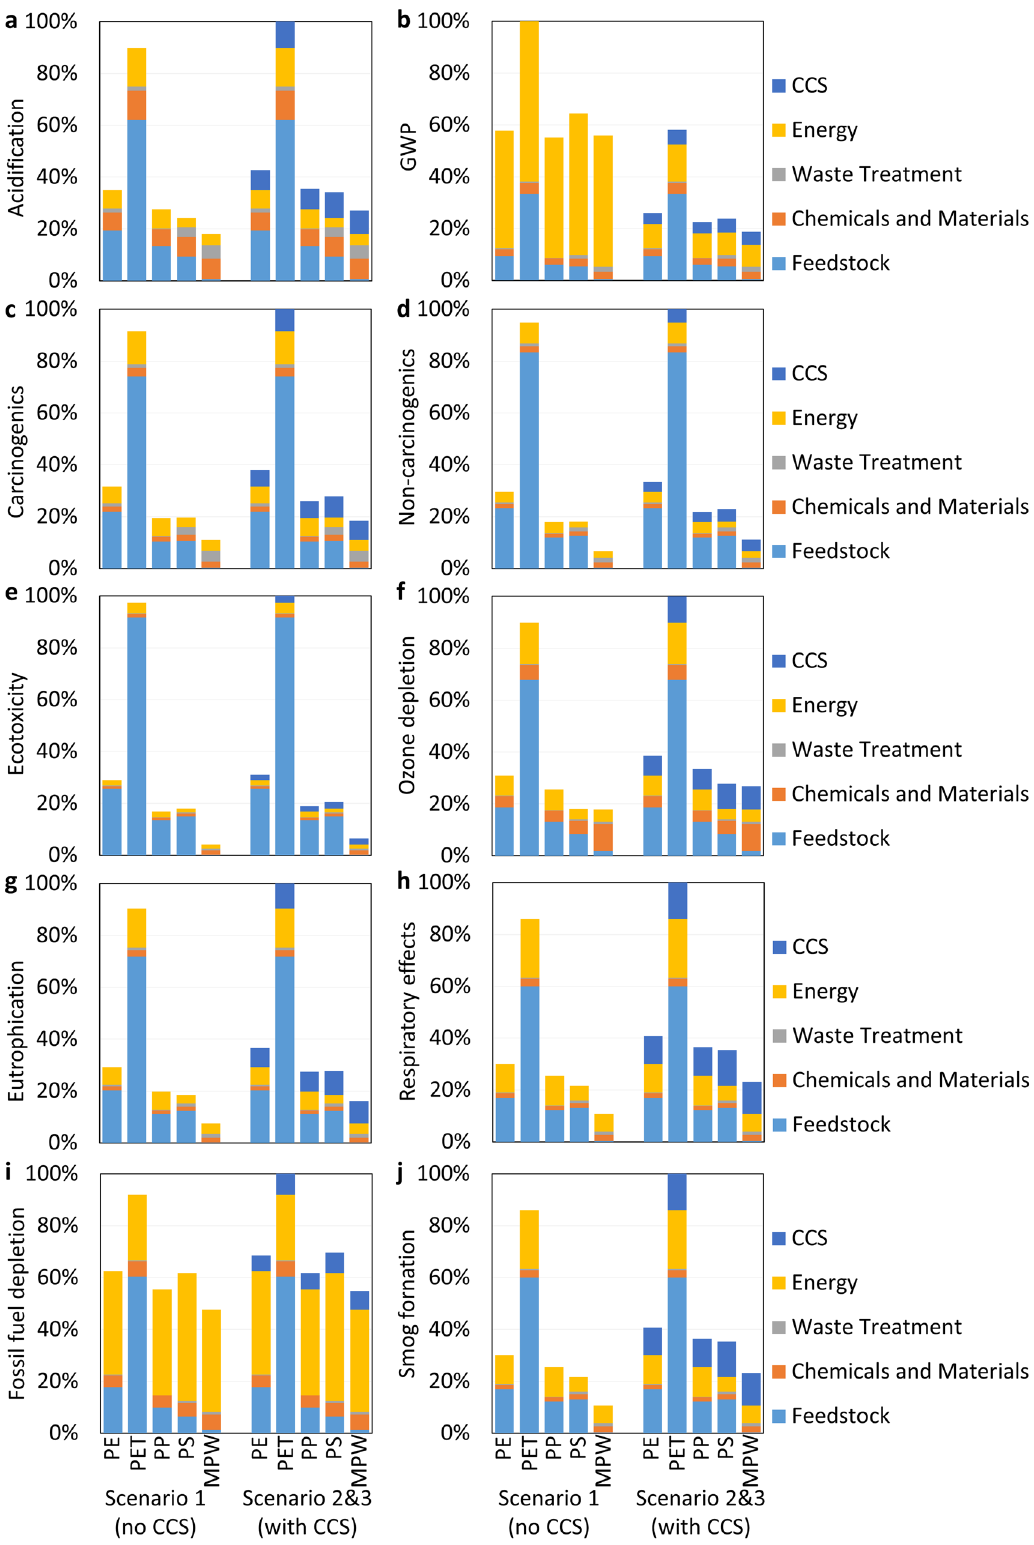
Fig. 6 Normalized Life Cycle Assessment results of fi ve cases with and without carbon capture and storage. a acidi fi cation; b Global Warming Potential c carcinogenics (human health); d non-carcinogenics (human health); e ecotoxicity; f ozone depletion; g eutrophication; h respiratory effects; i fossil fuel depletion; j smog formation. Scenario 1 does not have CCS; Scenarios 2 and 3 have CCS and the same LCA results (as the difference is the inclusion/ exclusion of carbon credits that affect TEA but not LCA). The results are decomposed into fi ve contributors. The LCA results of 1 kg H 2 in each impact category are normalized based on the largest result across Scenarios 1 –